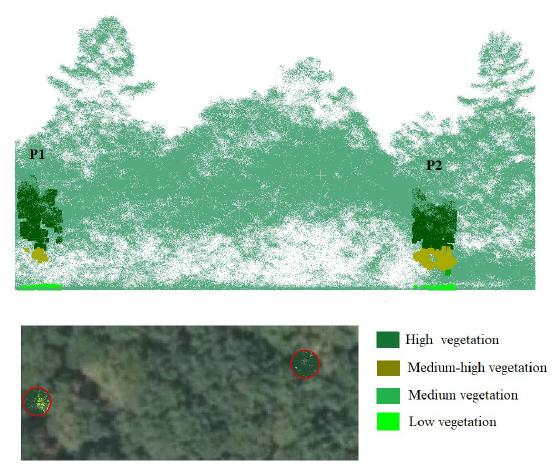
Figure 2 . Classification of vegetation points in both plots study